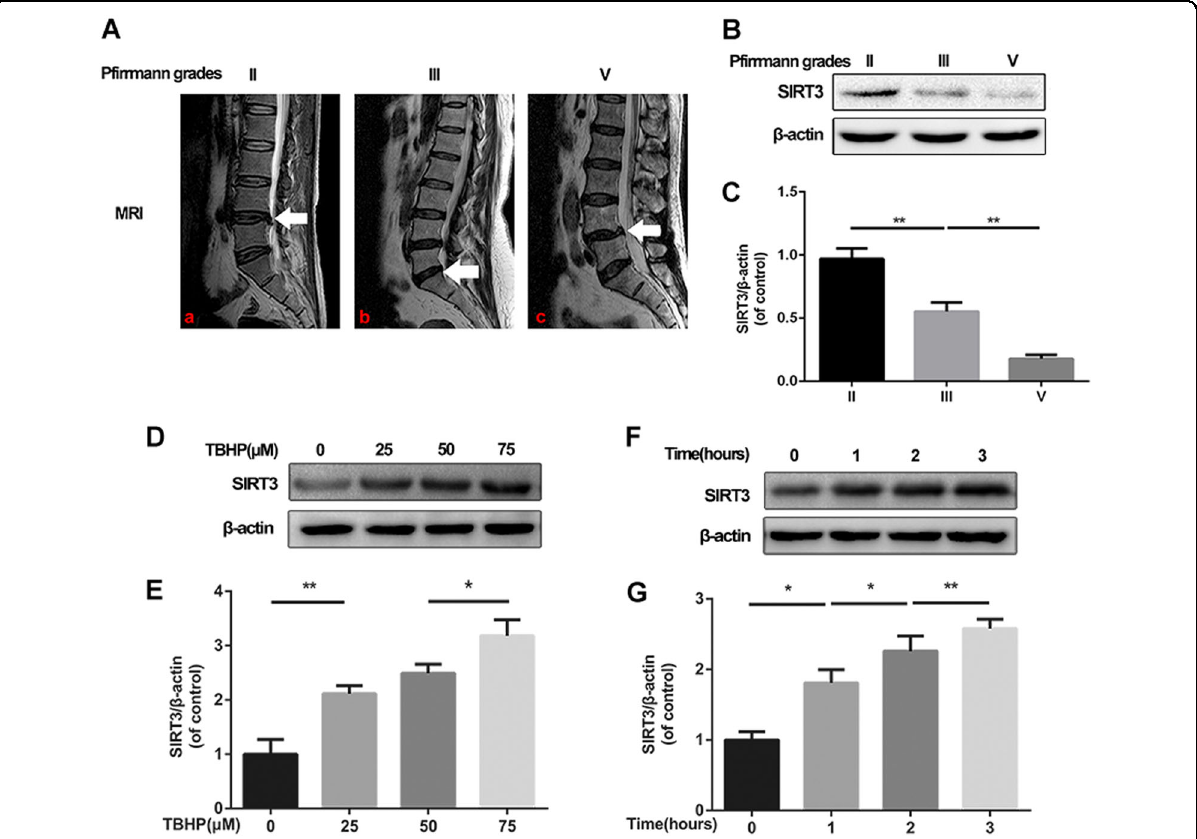
Fig. 1 The expression of SIRT3 decreases in degenerated human disc tissues and increases in TBHP-treated rat NPCs. a, b Representative MR images of three different degrees of IVDD patients. a P fi rrmann grade II patient, male, 46-years old, lumbar disc herniation. b P fi rrmann grade III patient, female, 53-years old, lumbar disc herniation. c P fi rrmann grade V patient, female, 51-years old, lumbar disc herniation. Nucleus pulposus samples from different patients of ages were collected for the measurement of SIRT3, with consistency in the degree of intervertebral disc degeneration. Western blot analysis and bar diagrams of SIRT3 showed that the protein levels of SIRT3 decreased in an age-dependent manner. c Representative Western blots and bar diagram of SIRT3 levels in each human NP tissue group (P fi rrmann grades II, III, and V). d, e The effect of different concentrations of TBHP on rat NPCs. f, g The effect of different durations of treatment with TBHP on rat NPCs. All experiments were performed in duplicates, and data are reported as the mean ± SD. * P < 0.05, ** P <